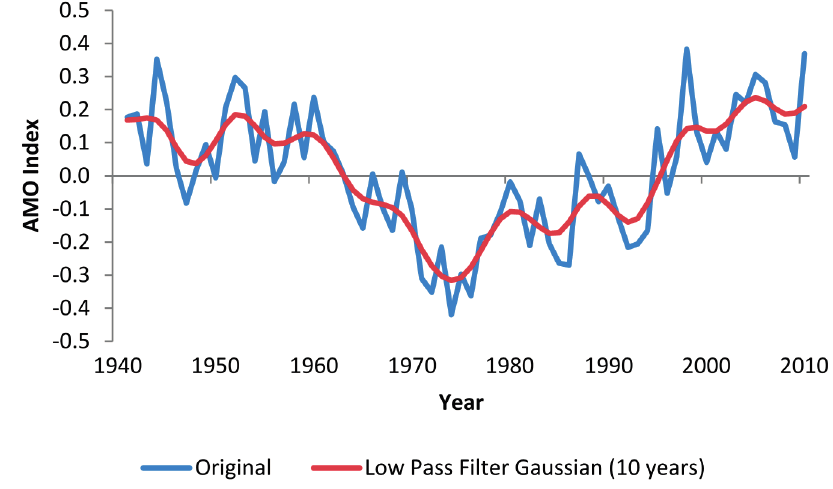
Figure 2. Atlantic Multidecadal Oscillation (AMO).